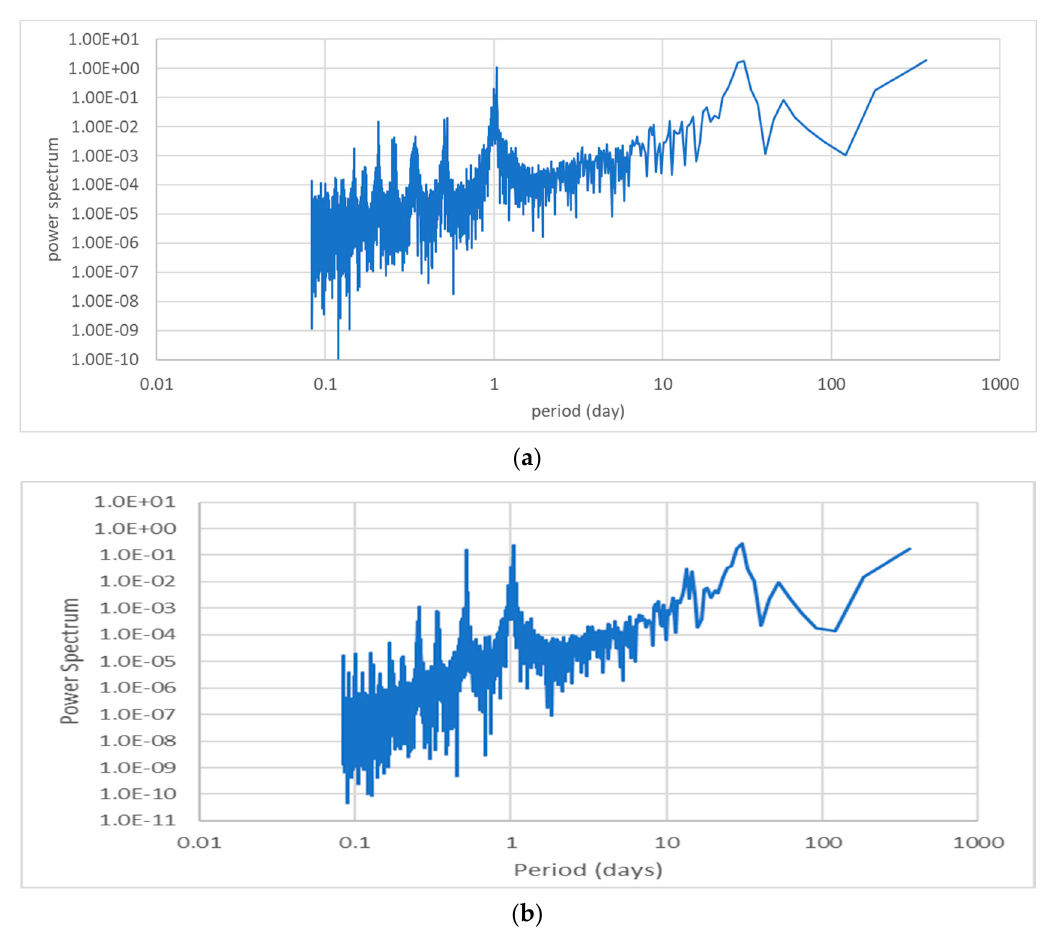
Figure 10. The time series of simulated global mean TOA OLR flux, the global mean longwave radiance in the Moon- based view, and the monthly mean of global TOA OLR flux.